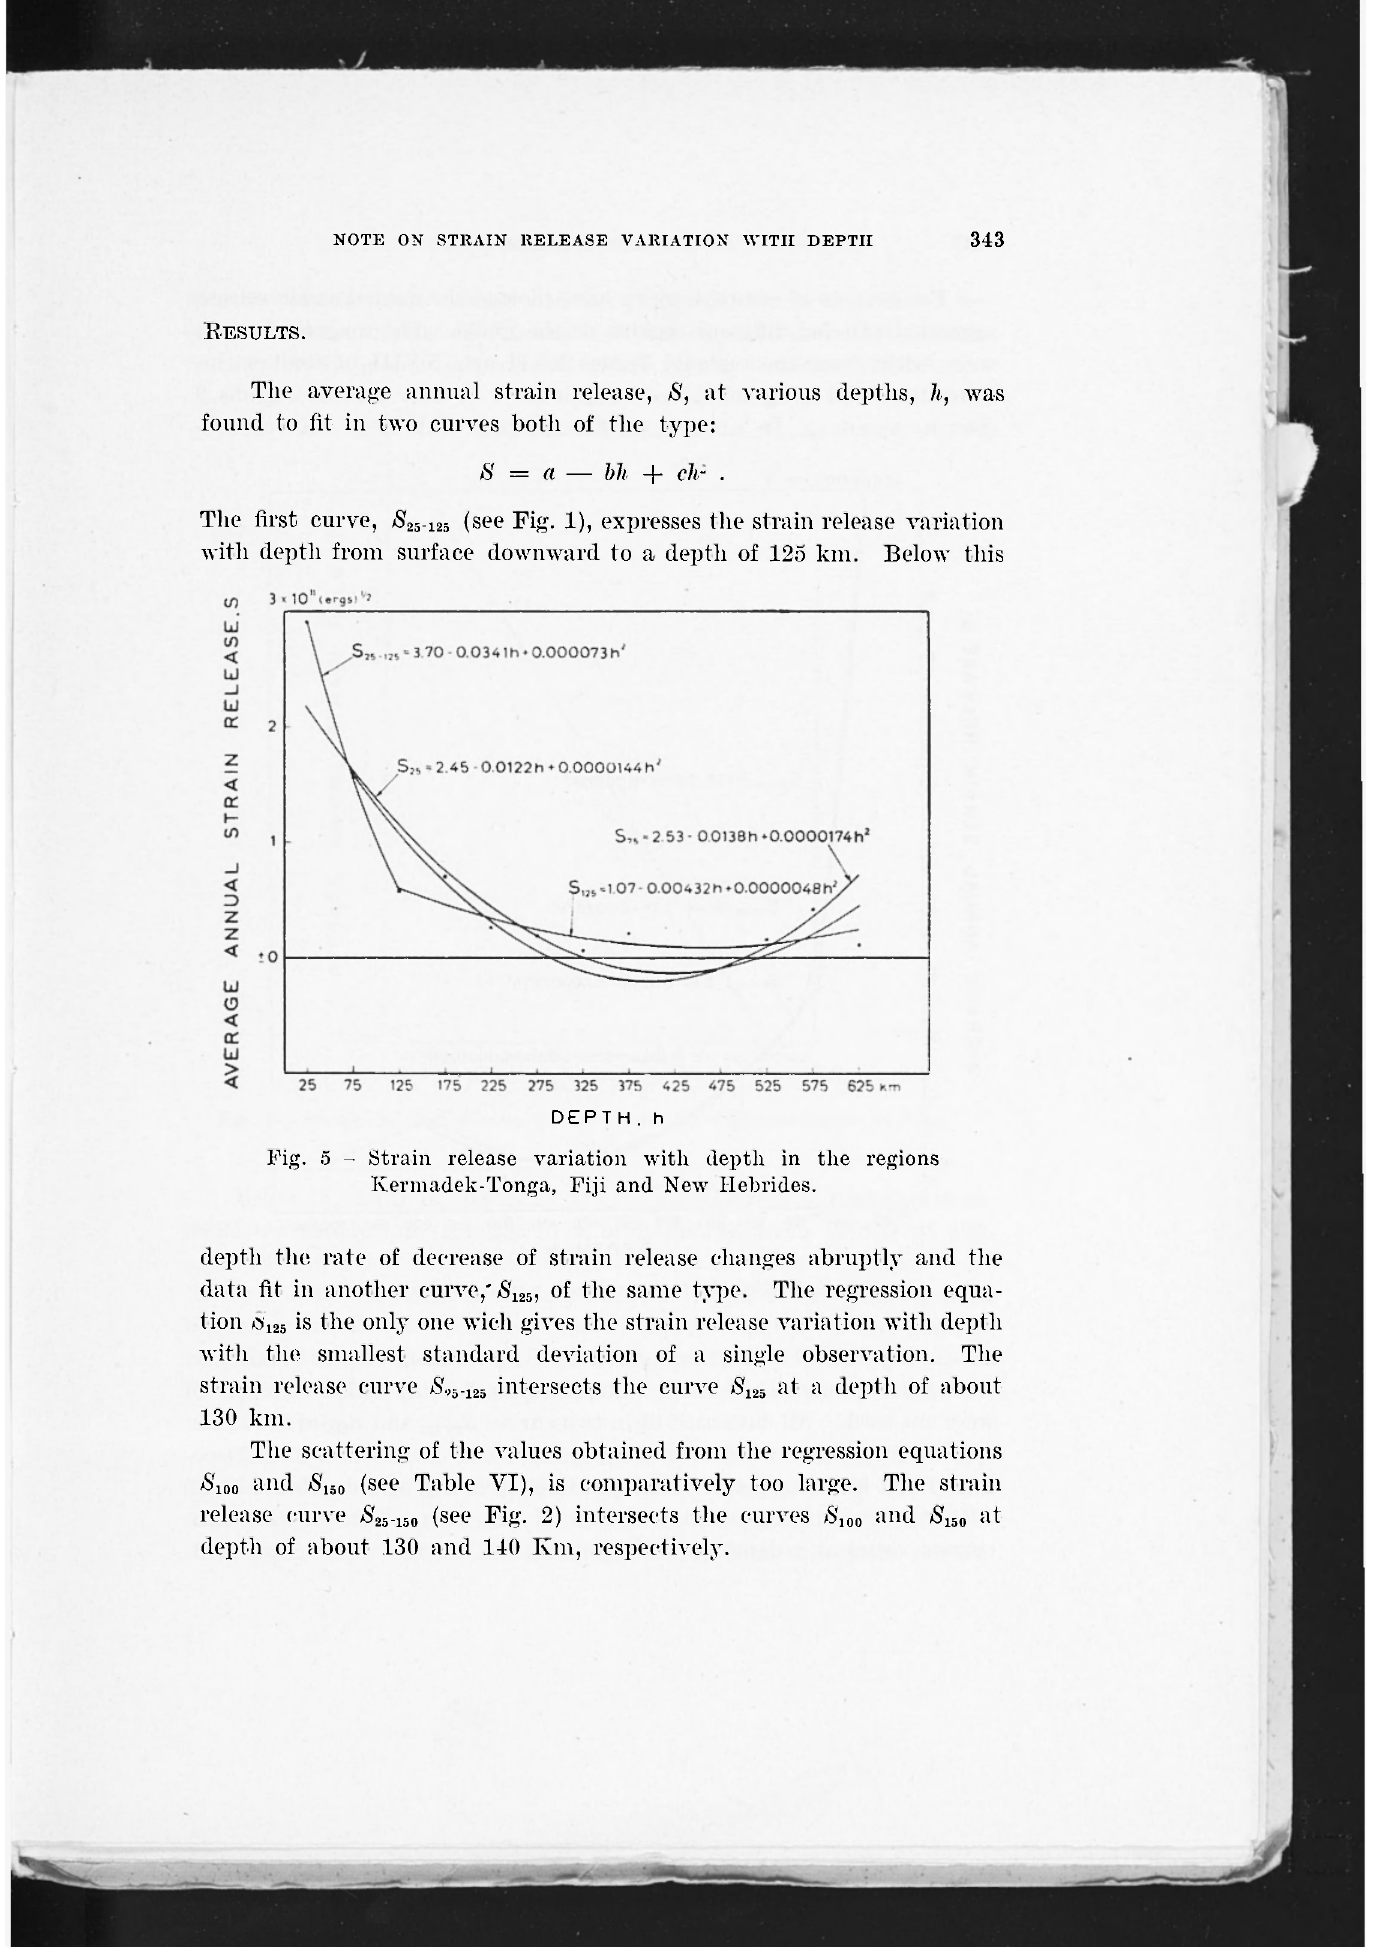
Fig. 5 - Strain release variation with depth in the regions Kermadek-Tonga, Fiji and New